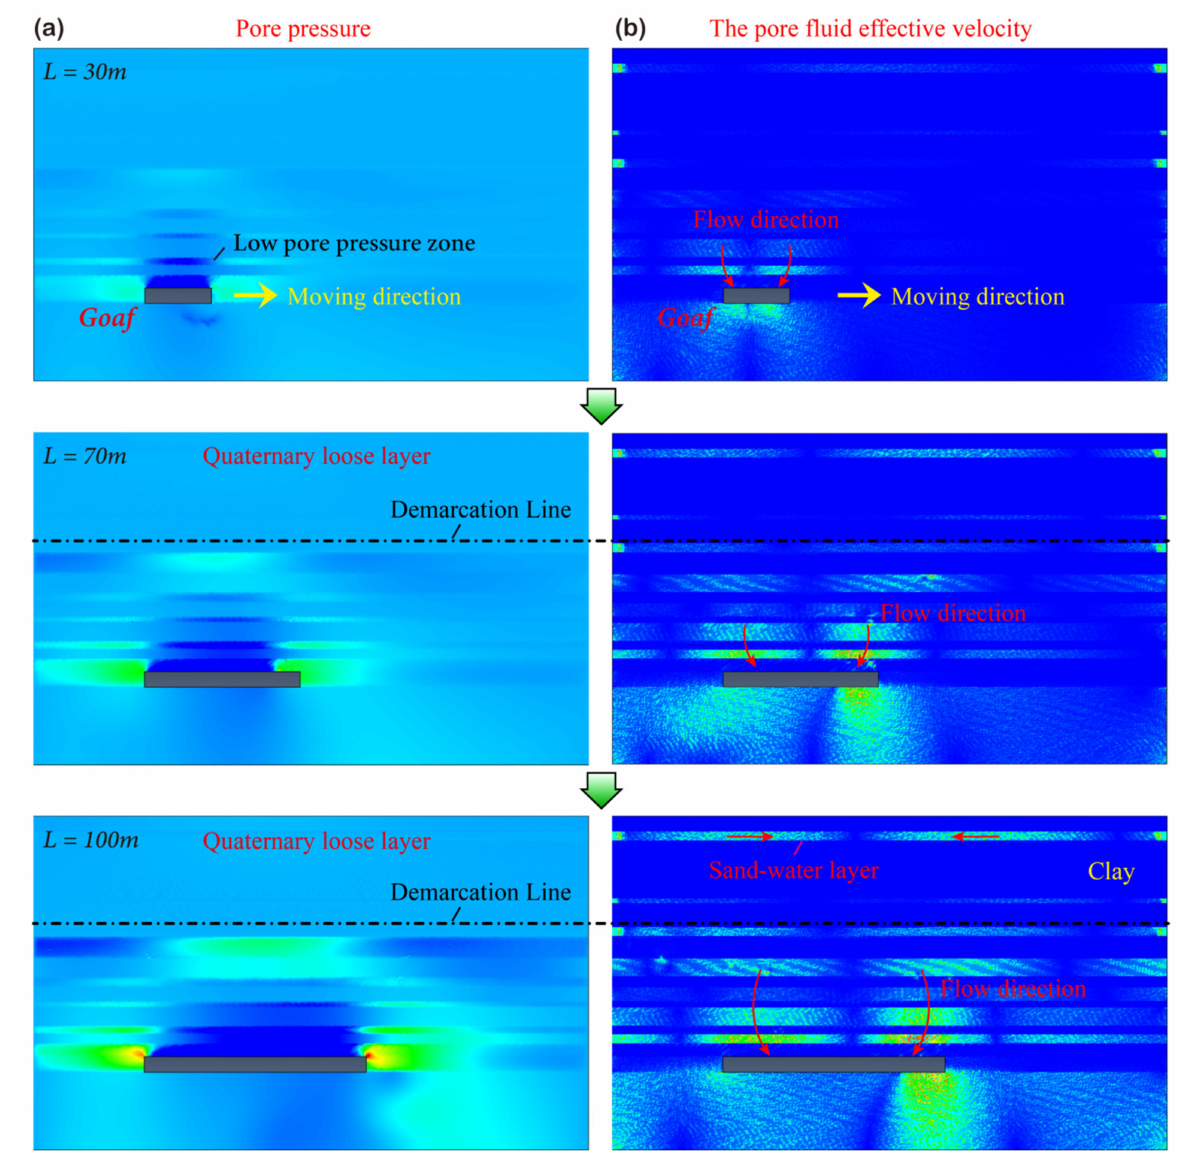
Figure 8. ( a ) Variation law of pore pressure; ( b ) Variation law of the pore fluid effective velocity. During the mining process of the 3301 working face, the change in water surge was monitored on site, as shown in Figure 9. During the mining period of the 3301 working face, the water inflow was relatively small (less than 6.0 m 3 /h). With the increase in the advancing distance of the 3301 working face, the water inflow did not increase significantly, relatively smooth changes. This shows that during the mining of the 3301 working face, the main source of water inflow was the sandstone aquifer water in the bedrock section, and the shallow groundwater and surface water did not enter the working face in large quantities with the mining of the coal seam. This also supports the seepage law of the roof overlying rock in Figure 8. This shows that the overall integrity of the clay layer is not damaged by mining, and its water insulation remains